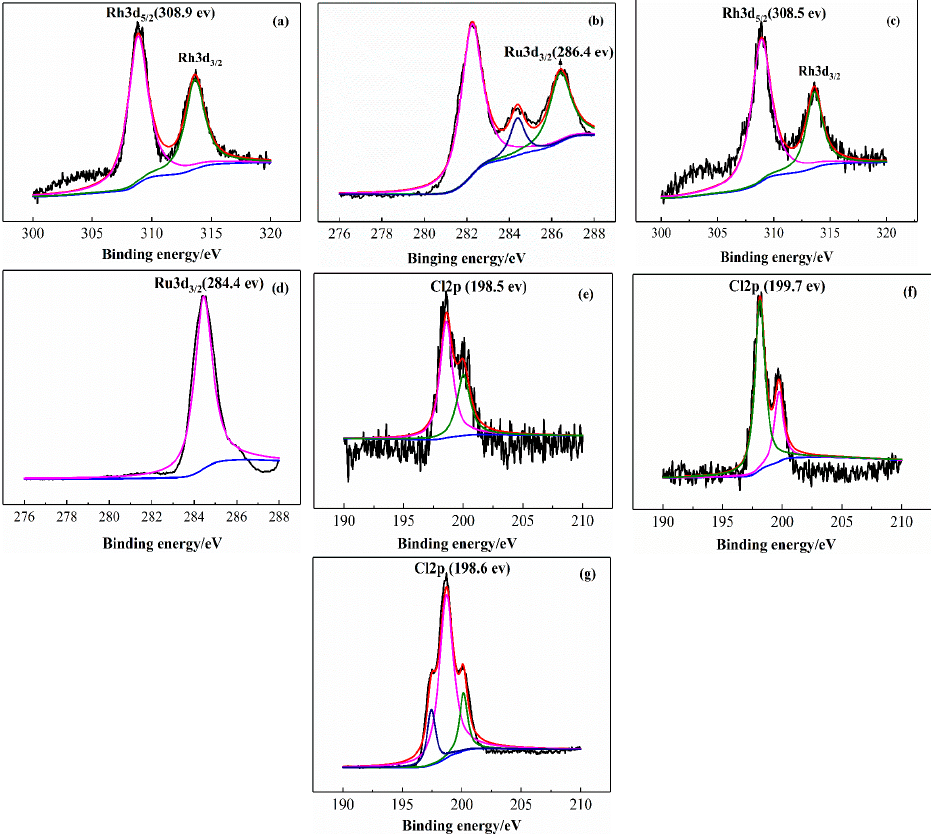
Figure 7. XPS spectra for Rh(I) / Ru(III) bimetallic catalyst and precursors: ( a ) XPS spectra of Rh (Rh 2 (CO) 4 Cl 2 ); ( b ) XPS spectra of Ru (RuCl 3 · 3H 2 O); ( c ) XPS spectra of Rh (Rh(I) / Ru(III) bimetallic catalyst); ( d ) XPS spectra of Ru (Rh(I) / Ru(III) bimetallic catalyst); ( e ) XPS spectra of Cl 2p (Rh 2 (CO) 4 Cl 2 ); ( f ) XPS spectra of Cl 2p (Rh(I) / Ru(III) bimetallic catalyst); ( g ) XPS spectra of Cl 2p (RuCl 3 · 3H 2 O).